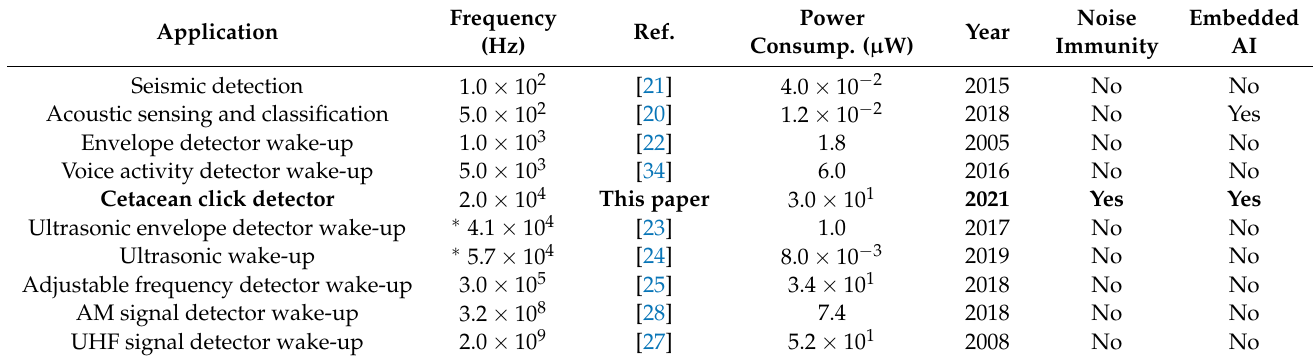
Table 1. Comparison of proposed cetacean click detector and existing wake-up.